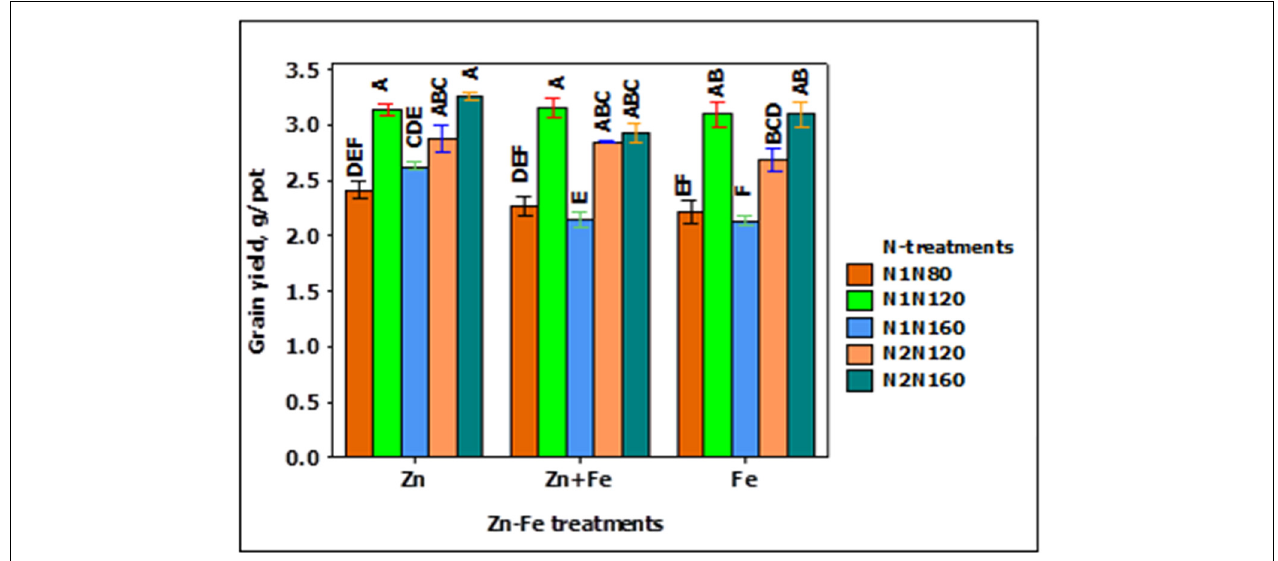
FIGURE 1 | Grain yield at N when Zn, Zn + Fe, and Fe applied to growth media at sowing. N1 and N2 for single and split N. 80, 120, and 160 stand for rate of N in kg ha − 1 . Bars with same alphabet at head are not significantly different at 5% level of significance.